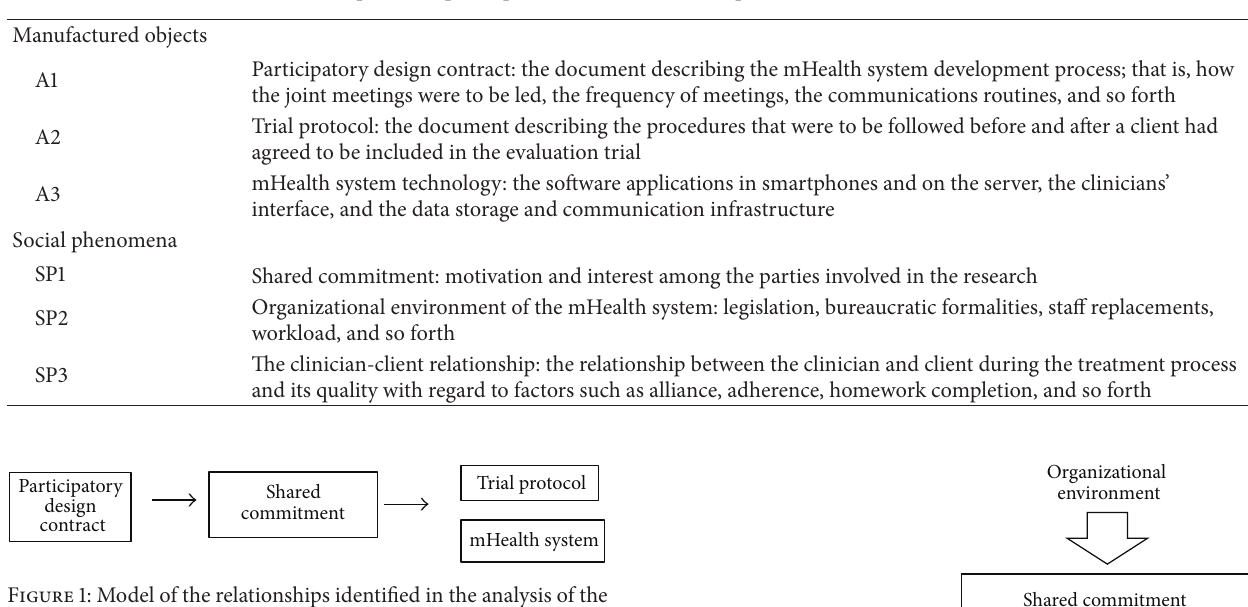
Table 1: Central concepts in the participants’ accounts of their experiences from the collaborative research.